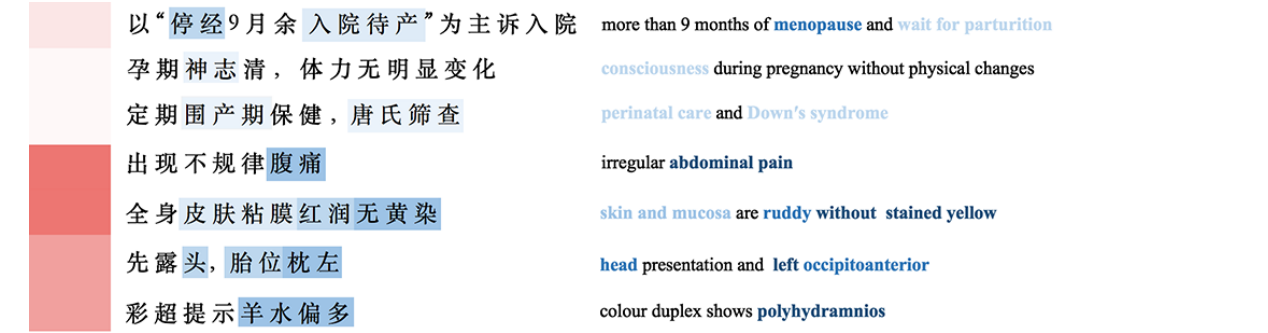
Figure 4. Visualization of attention in document encoder (attention